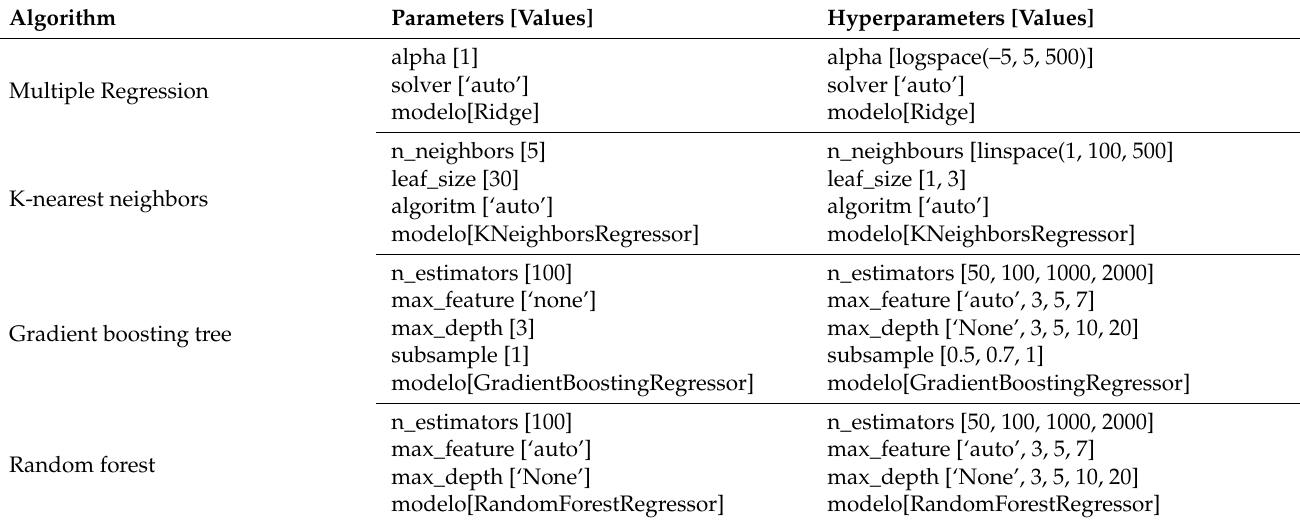
Table 6. Parameter and hyperparameter values for the ML